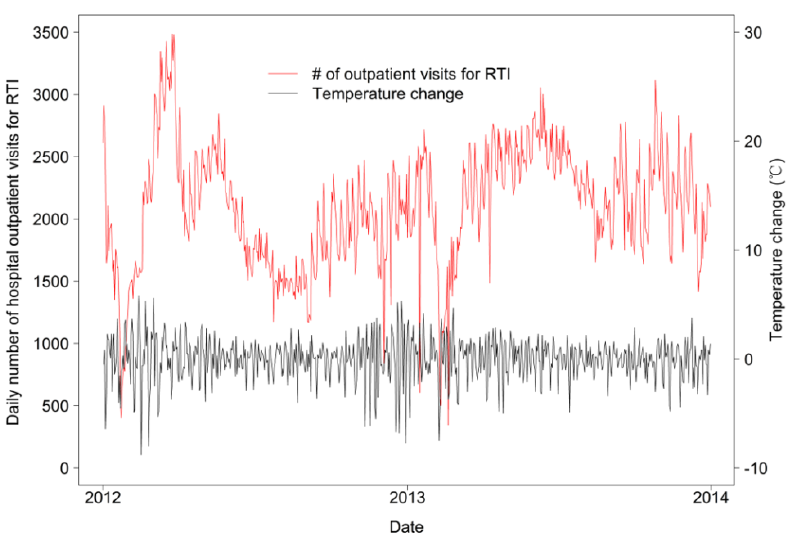
Figure 1. Daily number of outpatient visits for respiratory tract infections (RTIs) and temperature change versus time (January 2012–December